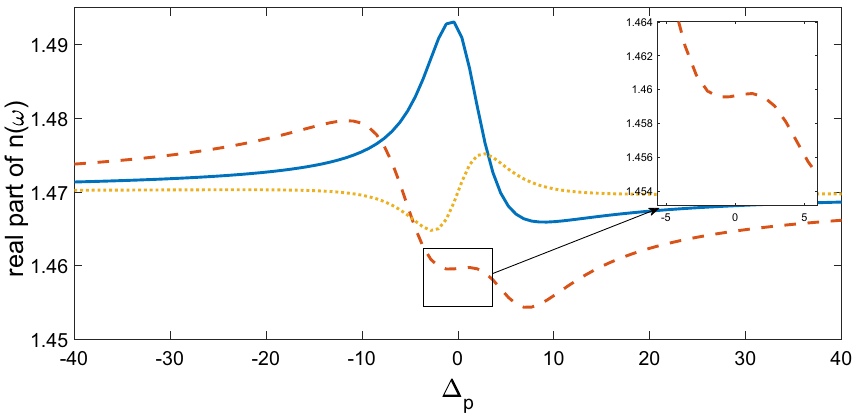
Figure 3. The real part of refractive index for � c = 0.6 γ , � d = 0.9 γ , �ϕ = 0 (solid line), � c = 0.6 γ , � d = 5 γ , �ϕ = 0 (dashed line), � c = 0.6 γ , � d = 0.9 γ , and �ϕ = π γ